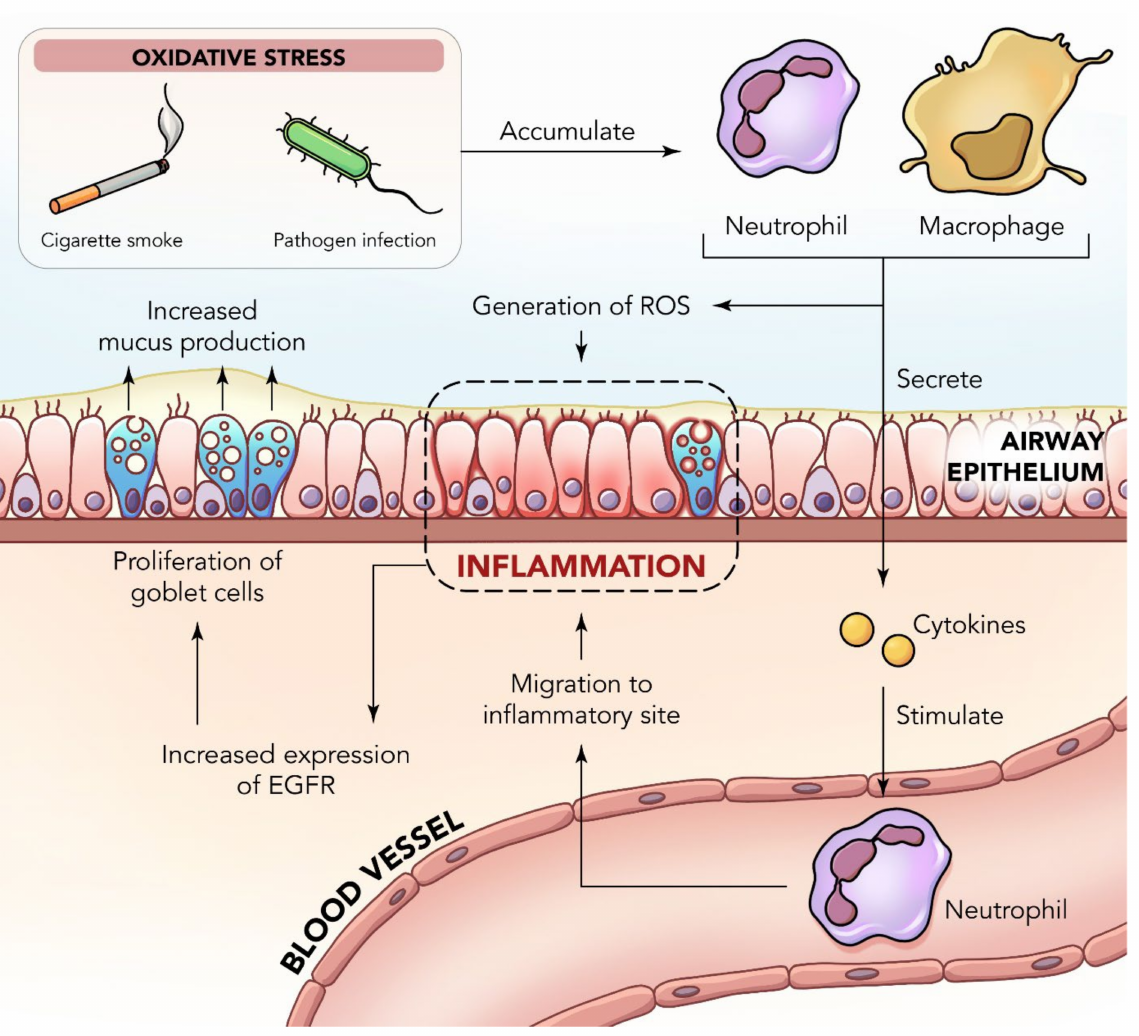
Figure 1. The mechanistic pathways leading to the pathogenesis of inflammatory lung diseases. ROS—Reactive Oxygen Species; EGFR—Epidermal Growth Factor